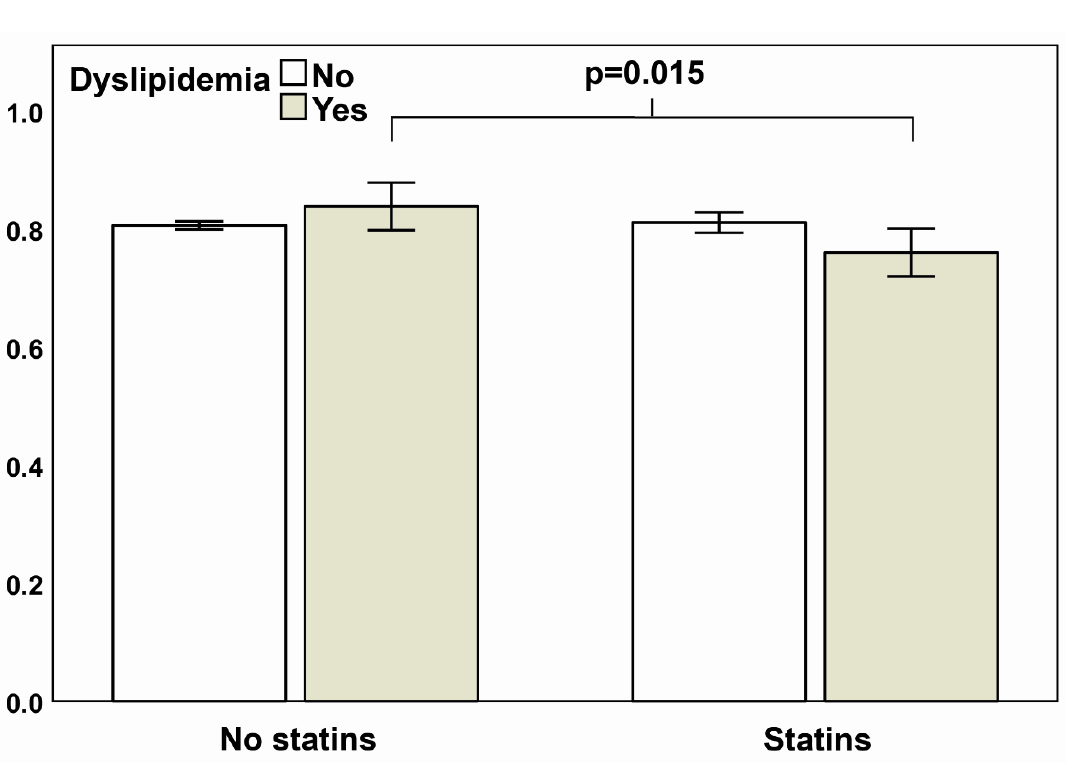
Figure 3. Impact of statins on amygdalar activation pattern. In a three-way ANOVA, an interaction term consisting of statins and dyslipidaemia was associated with a blunted amygdalar activity ( p = 0.015). Interaction terms consisting of sex, statins and/or dyslipidaemia were statistically not evident ( p > 0.05). The first left two bars show resting amygdalar activity of patients without statins and the right two bars depict patients with statins therapy. Further, white bars correspond to those patients without and grey bars to those patients with dyslipidemia. For reasons of improved readability, the variable “sex” was not included in this Figure. Error bars display standard error, SE. p -value is depicted.